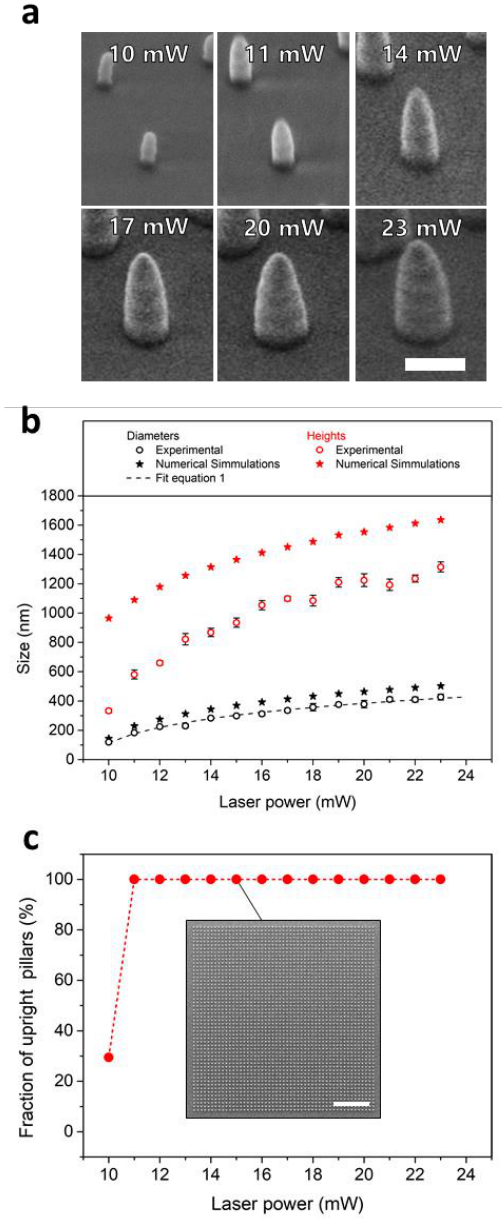
Figure 1. Sizes of nanopillars as a function of the applied laser power. ( a ) Scanning electron micrographs of nanopillars fabricated with different laser powers. The scale bar is 500 nm. ( b ) Diameters (black symbols) and heights (red symbols) of the nanopillars obtained from two-photon lithography (open circles) compared to numerical simulations (filled stars). The dashed line shows the fit of the pillar diameters using Equation (1) to estimate the threshold laser power of the photo resist. ( c ) Defect rates of optical gratings expressed as fractions of upright pillars in dependence on the applied laser power. The values were obtained from Scanning Electron Microscopy (SEM)-images as shown for 15 mW in the insert. The scale bar is 10 µm.